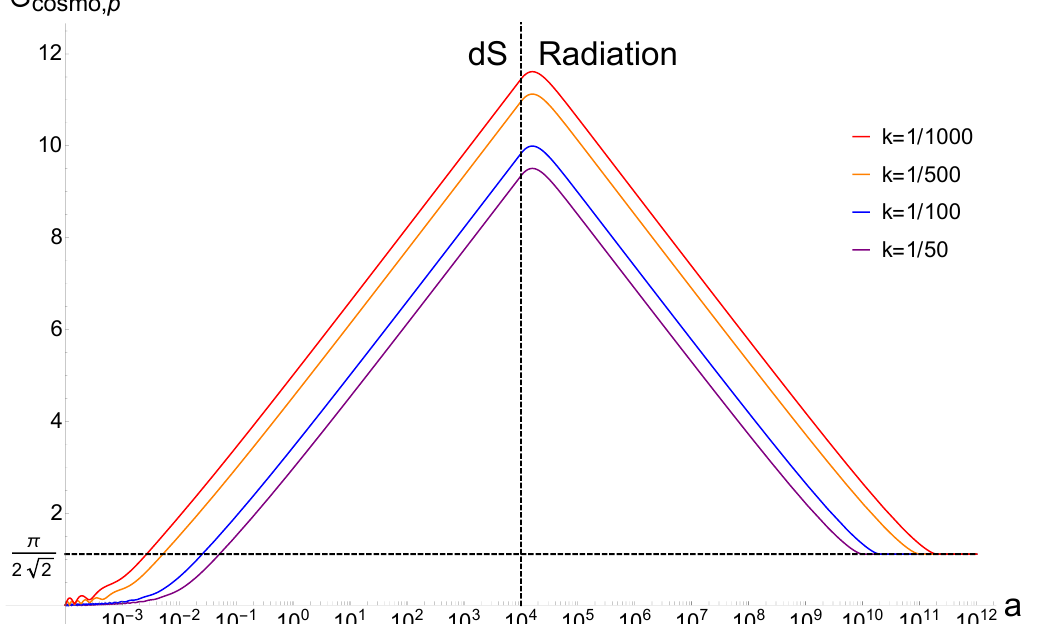
Figure 8. The complexity for cosmological perturbations in the simple cosmological background of figures 6, 7 with a simple model of decoherence in which the perturbations are described by the pure state (3.25) until they re-enter the horizon in the radiation era, after which they are described by the mixed state (3.30) with corresponding complexity (3.32). We see that all k -modes saturate √ to C cosmo , p ≈ π/ (2 2) upon horizon